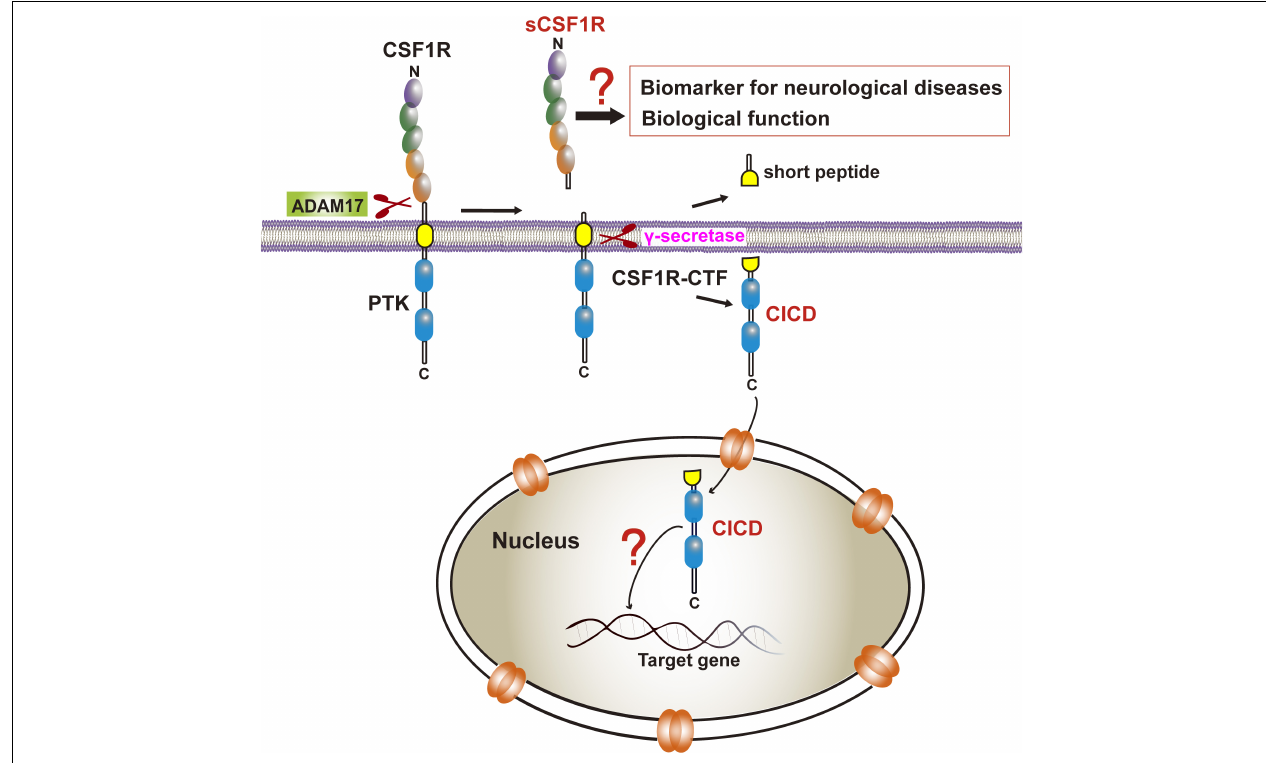
FIGURE 3 | CSF1R cleavage and its biological and clinical significance. CSF1R is sequentially cleaved by ADAM17 and γ -secretase to the release of sCSF1R and CICD. The former may be a biomarker of neurodegenerative diseases although the biological function needs to be determined. The latter translocates into the nucleus yet the transcriptional profiles in microglia remain